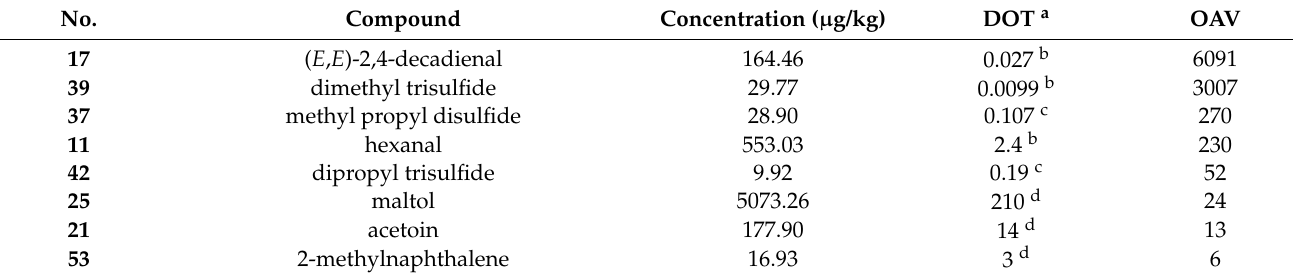
Table 3. OAVs of aroma-active compounds in